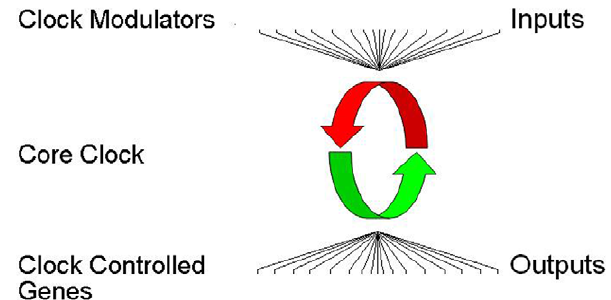
Figure 1. Organization of the extended clock network. The core clock oscillator is a set of , 18 genes that encode for transcriptional regulators (middle). These proteins are organized in complex feedback loops with positive (green) and negative (red) limbs that generate the , 24 hr rhythms in gene expression responsible for maintaining circadian rhythms. Upstream clock modulators influence the period and/or amplitude of rhythms by altering protein stability, cellular distribution, or phosphorylation of proteins within the core clock (top). Core clock transcriptional regulators generate expression rhythms in numerous downstream clock controlled genes that are not the ‘‘gears of the clock’’ involved in generating rhythms, but may be important effectors or ‘‘hands of the clock’’ (bottom).